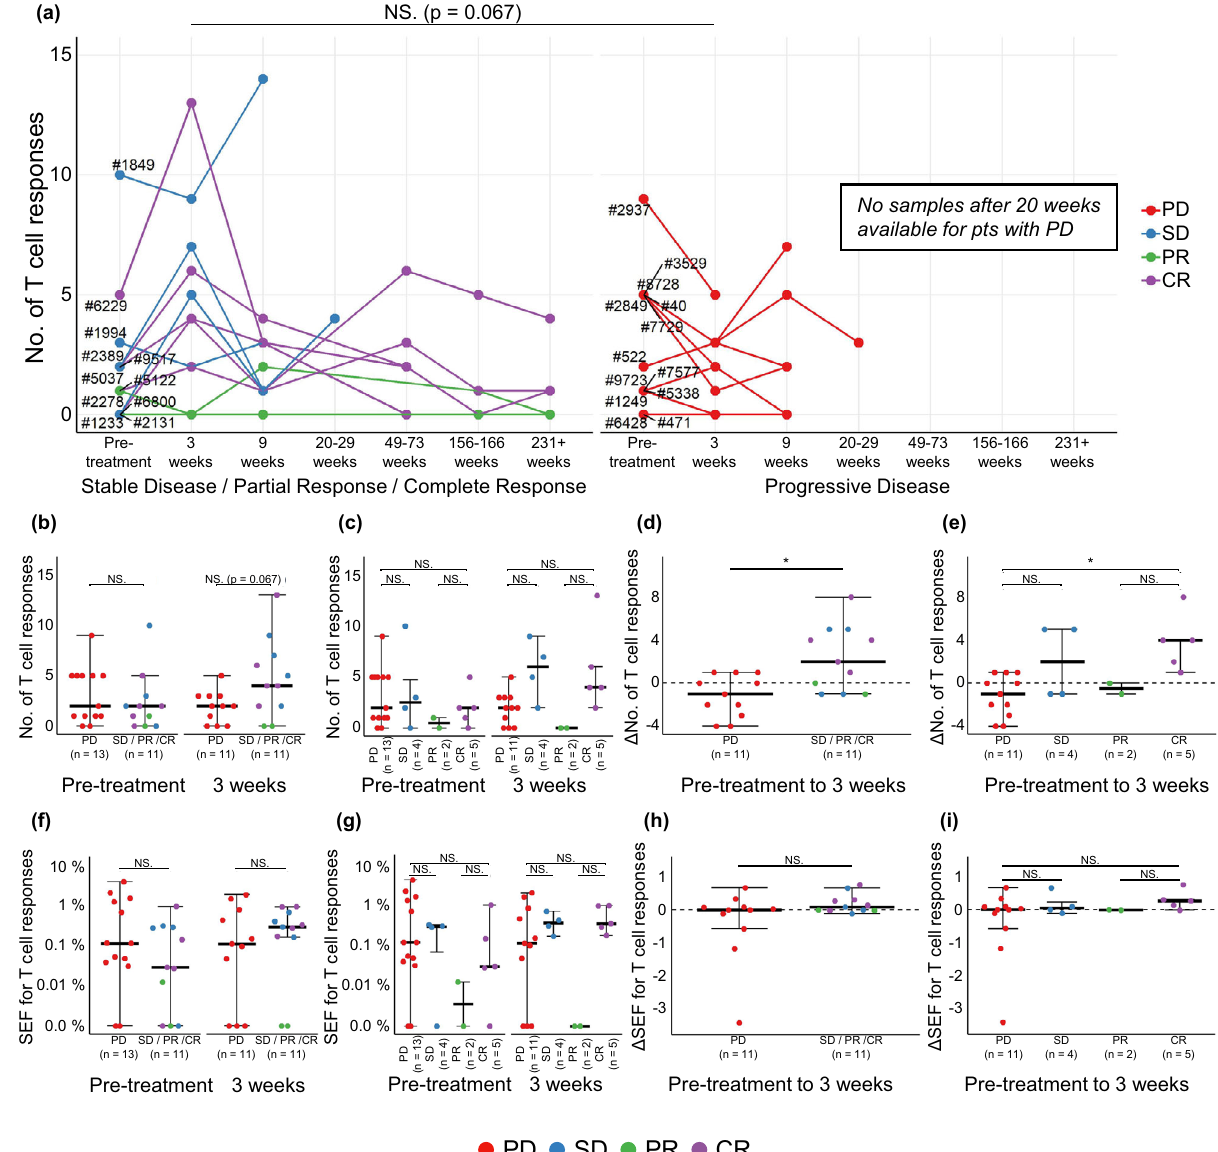
Fig. 3 Impact of NARTs in ICB. a No. of detected NART responses for all patients over course of therapy. Filled circles at respective time points indicate screening of the given sample. Patients are clustered according SD, PR, and CR ( n = 11 patients) and with PD ( n = 13 patients). b – c Number of detected NART responses prior to treatment ( n = 24 patients) and at three weeks post-treatment ( n = 22 patients) for each patient, d – e the change in number of NART responses between pre- and 3 weeks post-treatment for patients with minimum two time points sampled ( n = 22 patients), f – g SEF for NART populations at pre- and at 3 weeks post-treatment, and ( h – i ) change in SEF for NART populations between pre- and three weeks post-treatment, in all fi gures evaluated as PD compared to SD/PR/CR patients or individual Best RECIST 1.1 groups. For ( b ), ( d ), ( f ) + ( h ) groups were compared using non- parametric two-sided Mann – Whitney test and Kruskal – Wallis Dunn ’ s multiple comparison test for ( c ), ( e ), ( g ) + ( i ). For ( b – i ), data is presented as median values ± largest/smallest value within upper/lower quartile ± 1.5 IQR. NS. Not Signi fi cant, * p < 0.05. Source data are provided as a Source Data fi